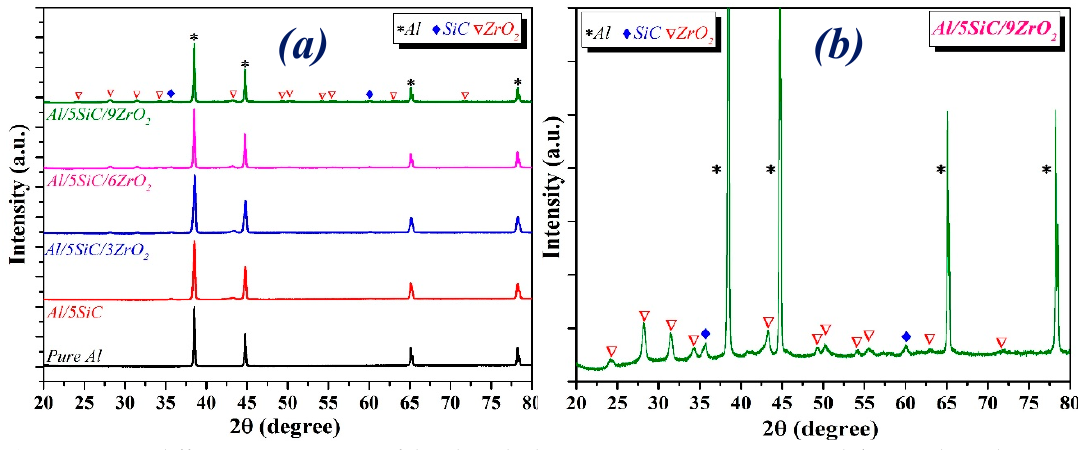
Figure 2. X-ray diffraction patterns ( a ) of developed Al-SiC-ZrO 2 nanocomposites and ( b ) an enlarged Figure 2. X-ray di ff raction patterns ( a ) of developed Al-SiC-ZrO2 nanocomposites and ( b ) an enlarged pattern of Al-5SiC-9ZrO 2 nanocomposites. pattern of Al-5SiC-9ZrO 2